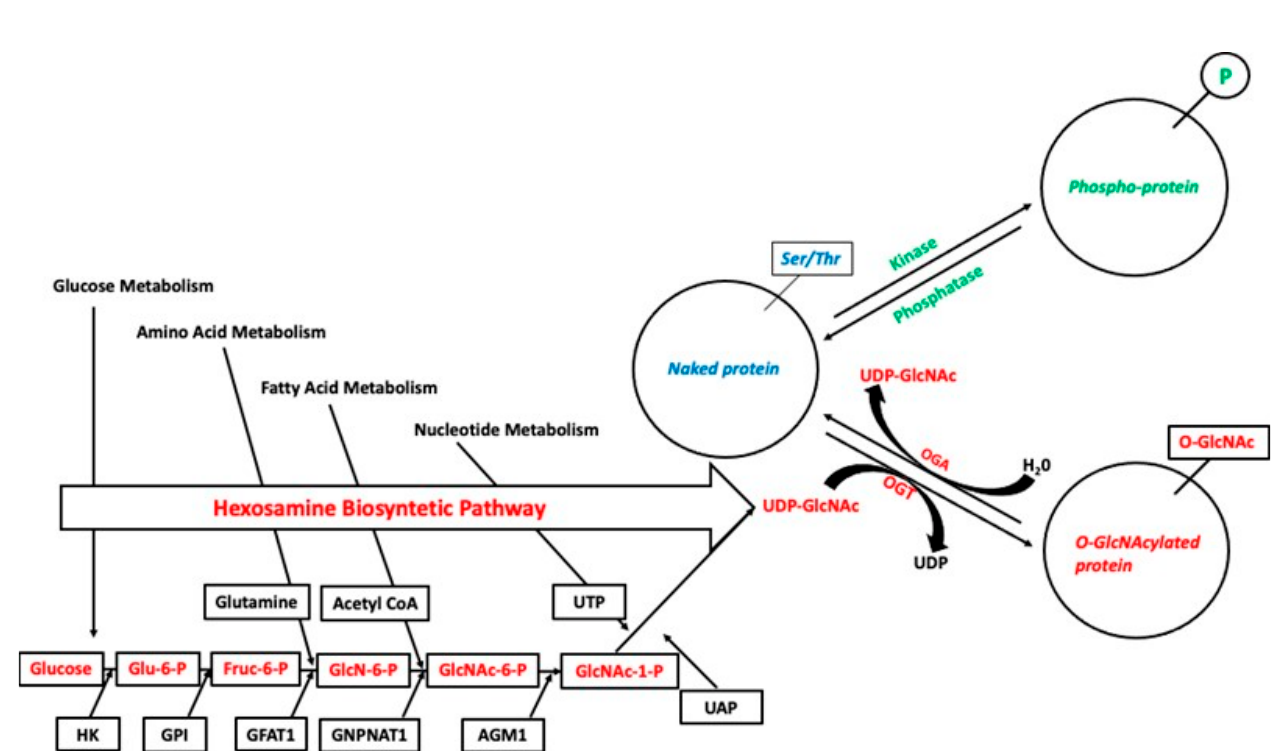
Figure 2. The Hexosamine Biosynthetic Pathway (HBP) and dynamic interplay between O-GlcNAc and O-phosphate. Once in the cells, glucose is enzymatically metabolized by Hexokinase (HK) to Glucose-6-Phosphate (Glc-6-P), which is then converted by Glc-6-P isomerase (GPI) into Glc-6-P to Fructose-6-phosphate (Fruc-6-P). About 3–5% of Fruc-6-P is metabolized to Glucosamine-6-phosphate (GlcN-6-P) by Glutamine Fructose-6-phosphate AmidoTransferase (GFAT). Glucosamine-6-Phosphate N-Acetyltransferase 1 (GNPNAT1) utilizes acetyl-CoA to convert GlcN-6-P into N-Acetylglucosamine-6-Phosphate (GlcNAc-6-P), which is then converted by Phospho-Acetyl Glucosamine Mutase 1 (AGM1) into N-acetylglucosamine-1-phosphate (GlcNAc-1-P). By utilizing Uridine Triphosphate (UTP), UDP-N-Acetylglucosamine Pyrophosphorylase (UAP) converts GlcNAc-1-P to Uridine diphosphate N-acetylglucosamine (UDP-GlcNAc). O-GlcNac modification and phosphorylation are reciprocal events because the site of attachment is the same or is adjacent to Ser/Thr residues. Two highly conserved enzymes mediate the addition and removal of the UDP-GlcNAc: OGlcNAc transferase (OGT) and O-GlcNAcase (OGA), respectively.